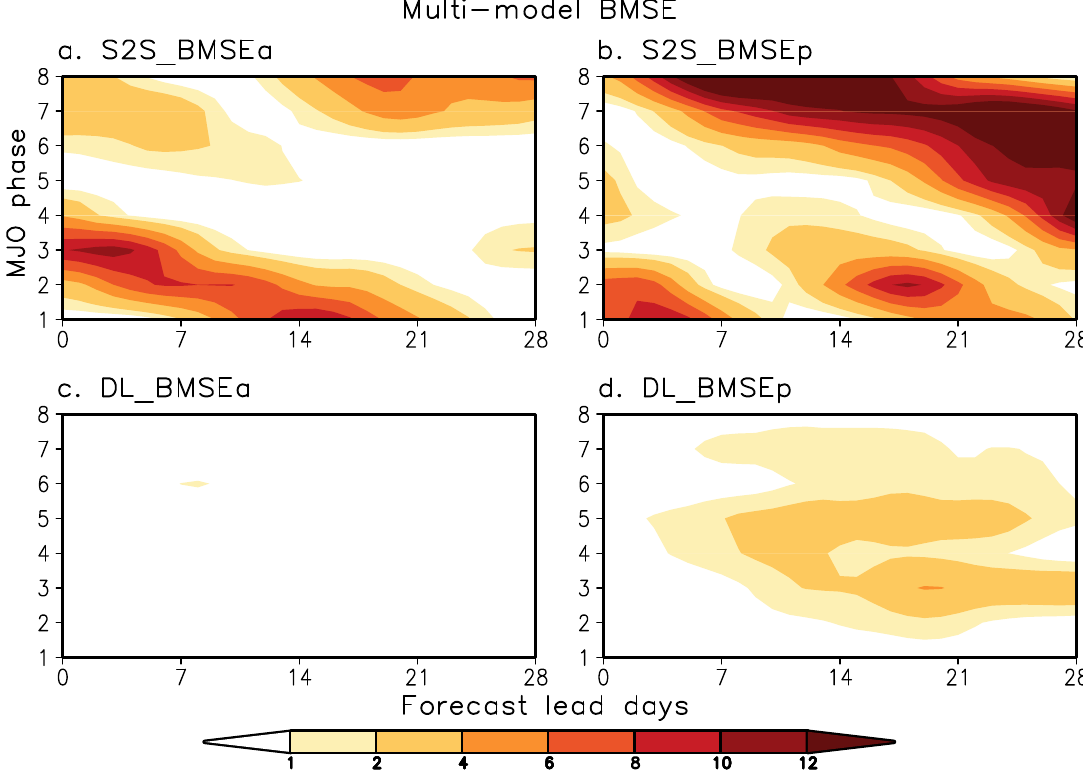
Fig. 2 Forecast errors in multi-model mean S2S reforecasts and DL-corrections. Multi-model mean bivariate root-mean-squared error (BMSE) as a function of initial MJO phases and forecast lead days for (top) Subseasonal-to-seasonal (S2S) reforecasts and (bottom) Deep learning (DL)-corrections. BMSE is divided into ( a , c ) amplitude error (BMSEa) and ( b , d ) phase error (BMSEp) for the Real-time Multivariate MJO indices (RMMs) composite shown in Fig. 1. Values are multiplied by 100. Note that a three-day moving average is